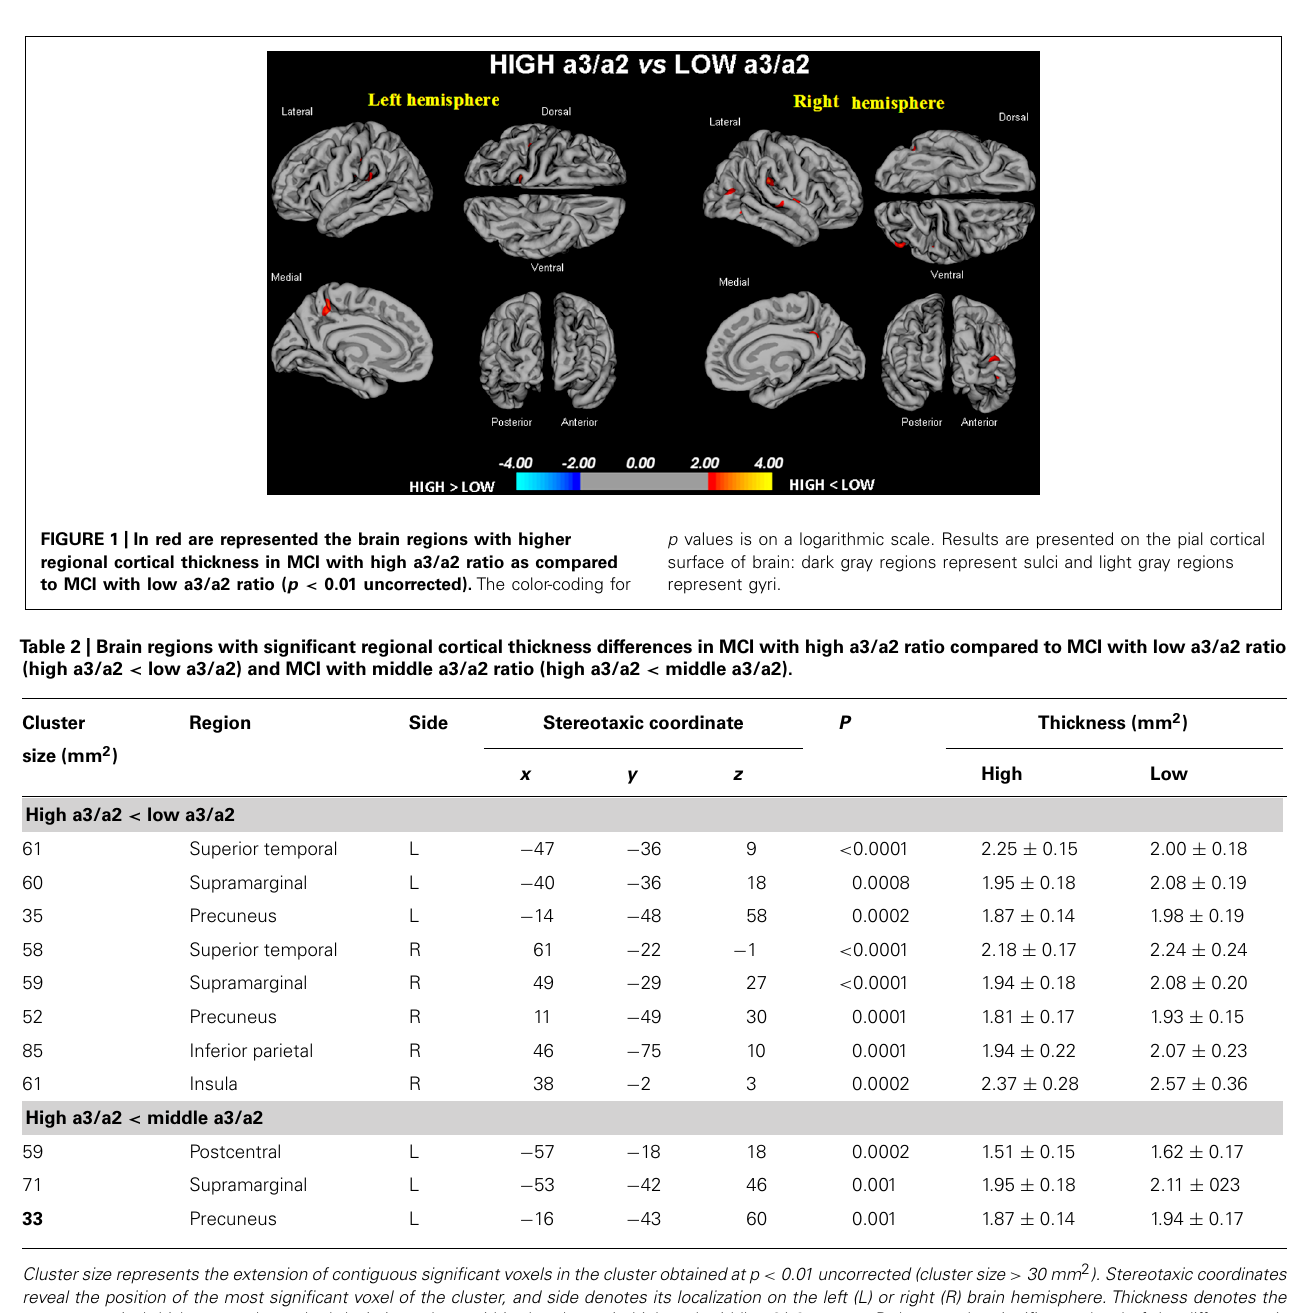
FIGURE 1 | In red are represented the brain regions with higher regional cortical thickness in MCI with high a3/a2 ratio as compared to MCI with low a3/a2 ratio ( p < 0.01 uncorrected). The color-coding for